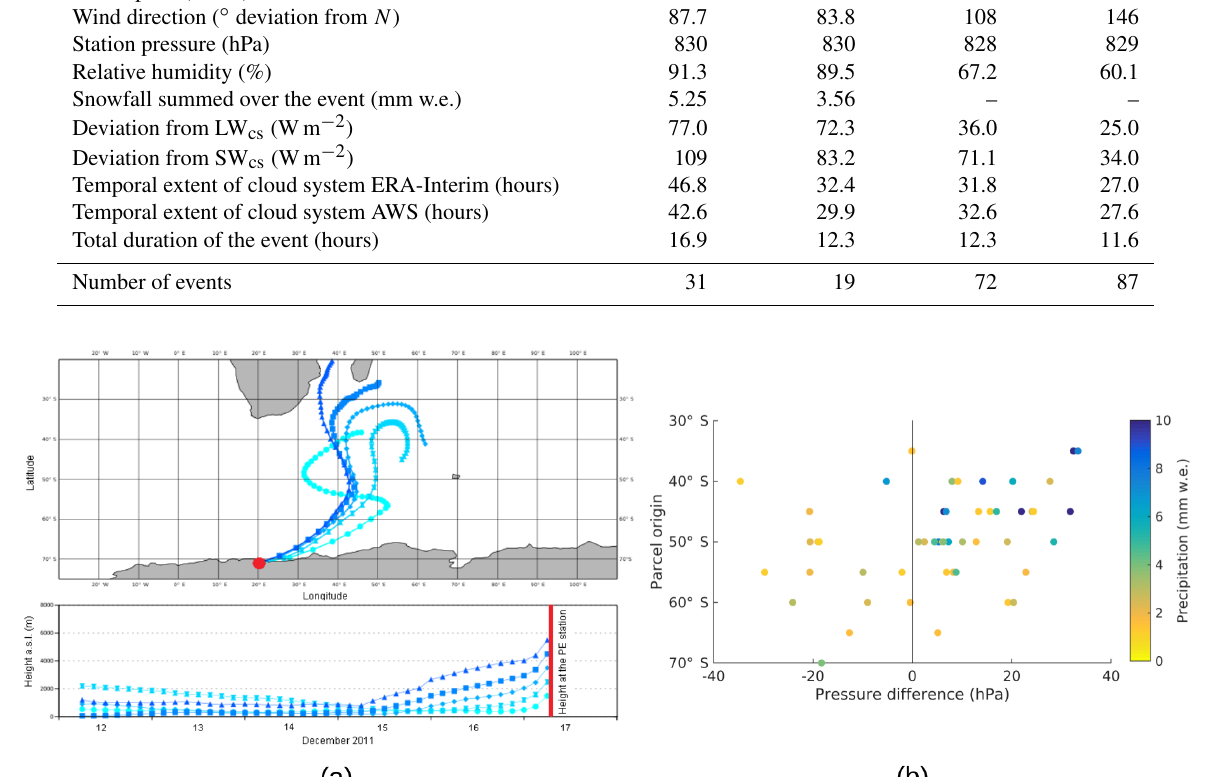
Figure 5. (a) Back trajectories for the snowfall event on 17 December 2011 at the Princess Elisabeth station for different heights (start at 06:00UTC). The red dot (top panel) denotes the location of the Princess Elisabeth station, while the red line (bottom panel) shows the time the snowfall event arrived at the station. (b) Relationship between the transport capacity of the cyclones (based on the pressure difference between the Princess Elisabeth station and 0 ◦ E, 62 ◦ S), the origin of the air masses (based on the origin of the back trajectories arriving at the Princess Elisabeth station at altitudes below 3000ma.s.l. five days prior to the event) and the total amount of snowfall for all detected events at the Princess Elisabeth station during 2010–2016. Positive values for the pressure difference denote the presence of a cyclone north-west of the Princess Elisabeth station, while negative values indicate the absence of a